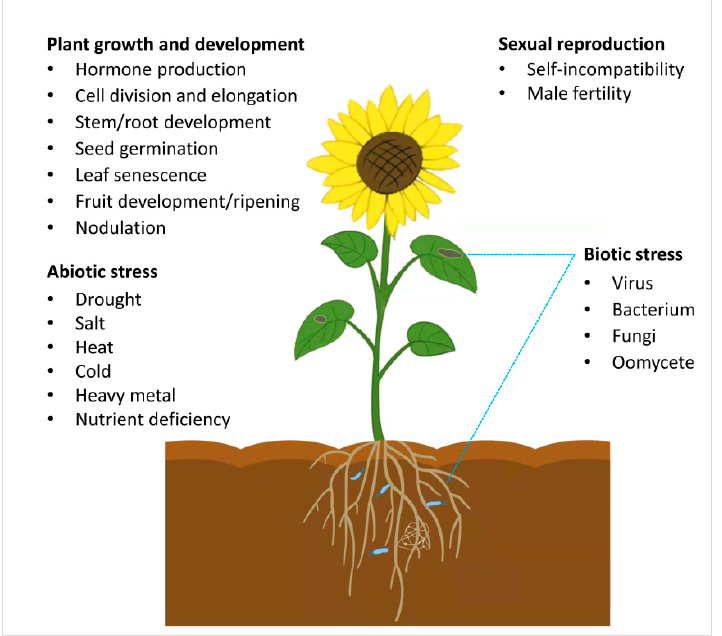
Figure 1. The roles of PUBs in plant growth and development and response to biotic and abiotic